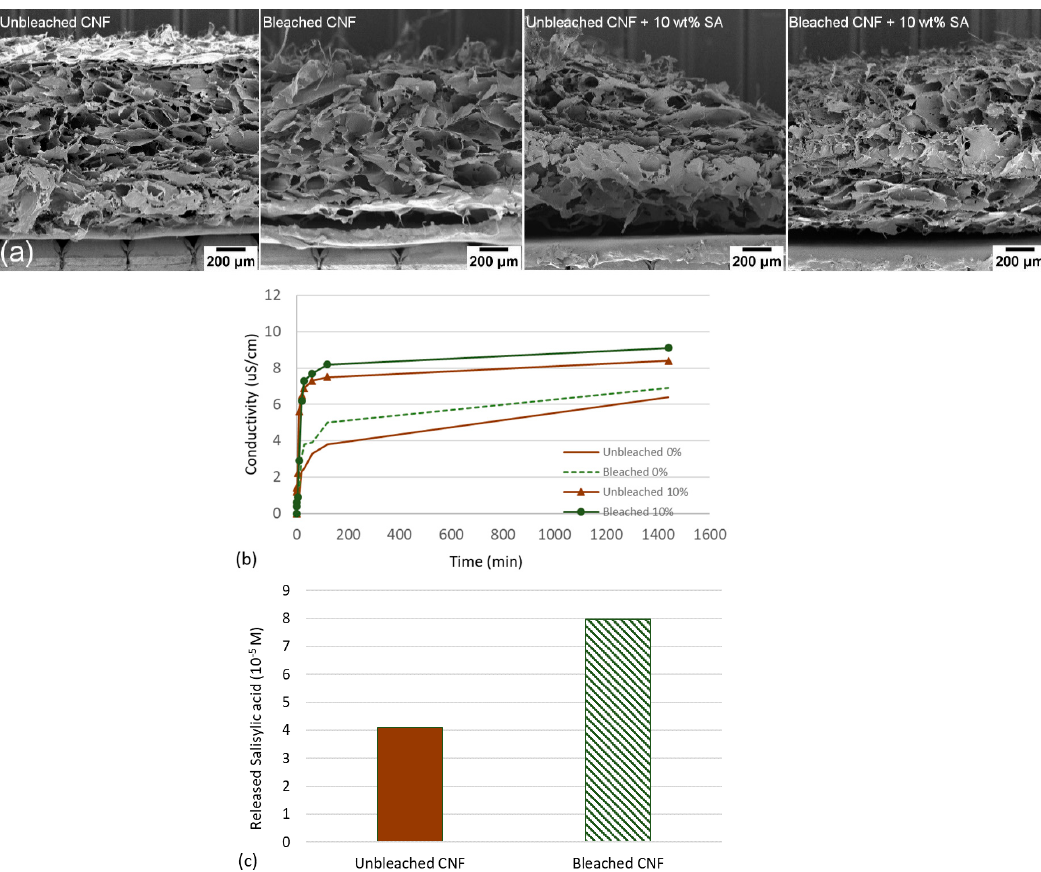
Figure 3. Images of bleached and unbleached CNFs hydrogels ( a ) and freeze-dried aerogels ( b ). The freeze-dried aerogel samples were approx. 5 mm in diameter and 10 mm in height. Note the slightly different yellow color caused by the lignin content in the unbleached CNF sample. SEM images of the unbleached ( c ) and bleached ( d ) freeze-dried aerogels. The SEM images were acquired at 100× magnification.